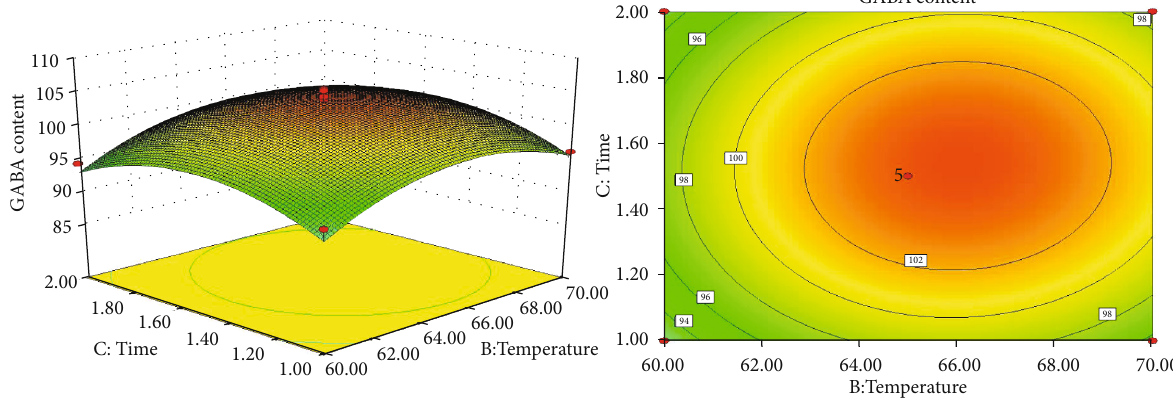
Figure 19: Response surface and contour diagram of time and temperature in fl uence on GABA content.